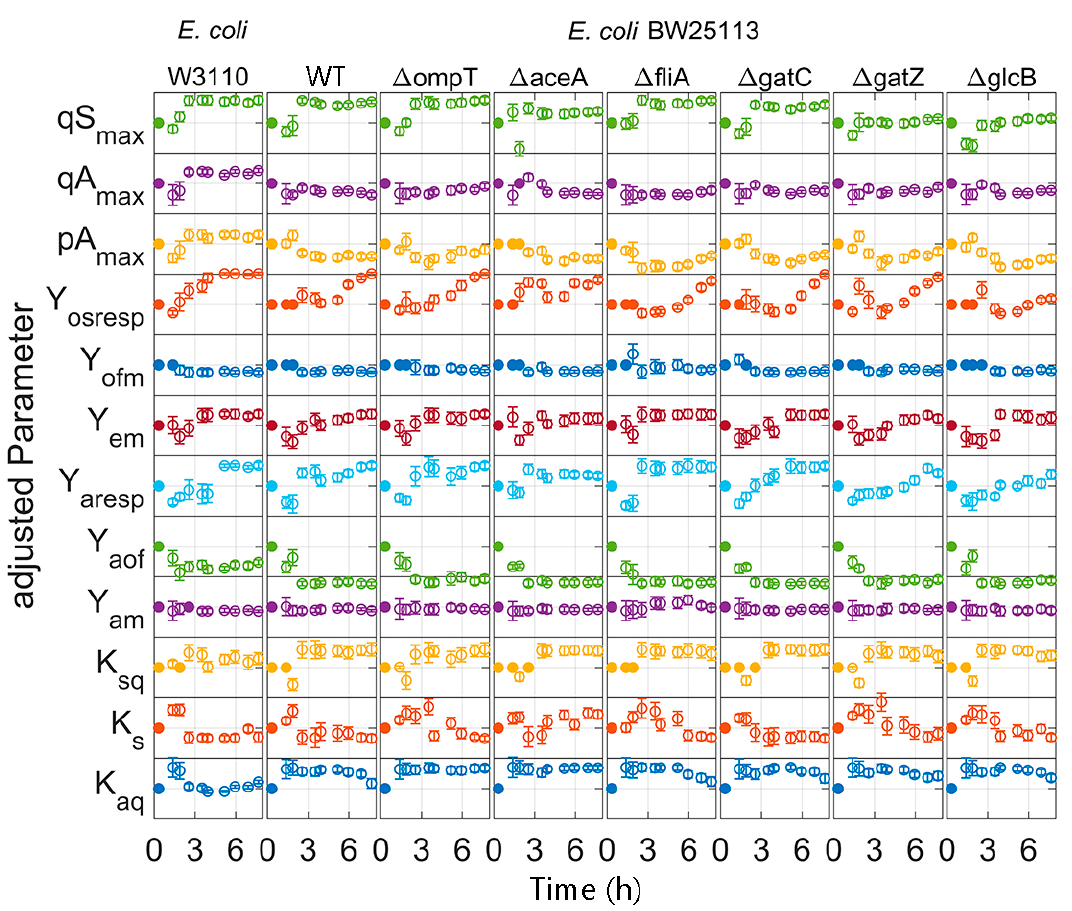
Figure 7. Adjusted parameters of the time for each E. coli strain: Parameters are normalized to the initial value and scaled to three times the standard derivation. Filled dots: parameter fixed by the subset selection; open dots: estimated parameter.